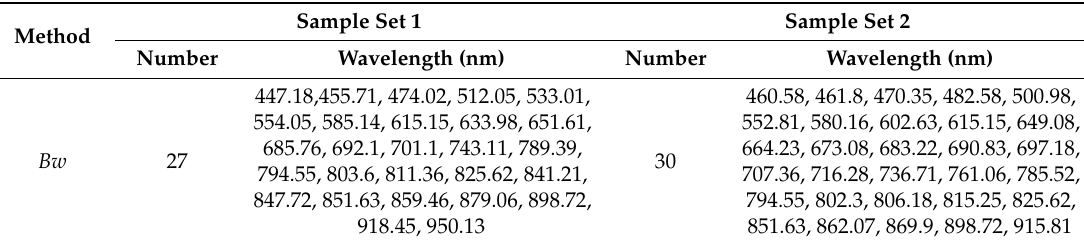
Table 6. Optimal wavelengths selection of sample set 1 and 2 selected by Bw using sample average